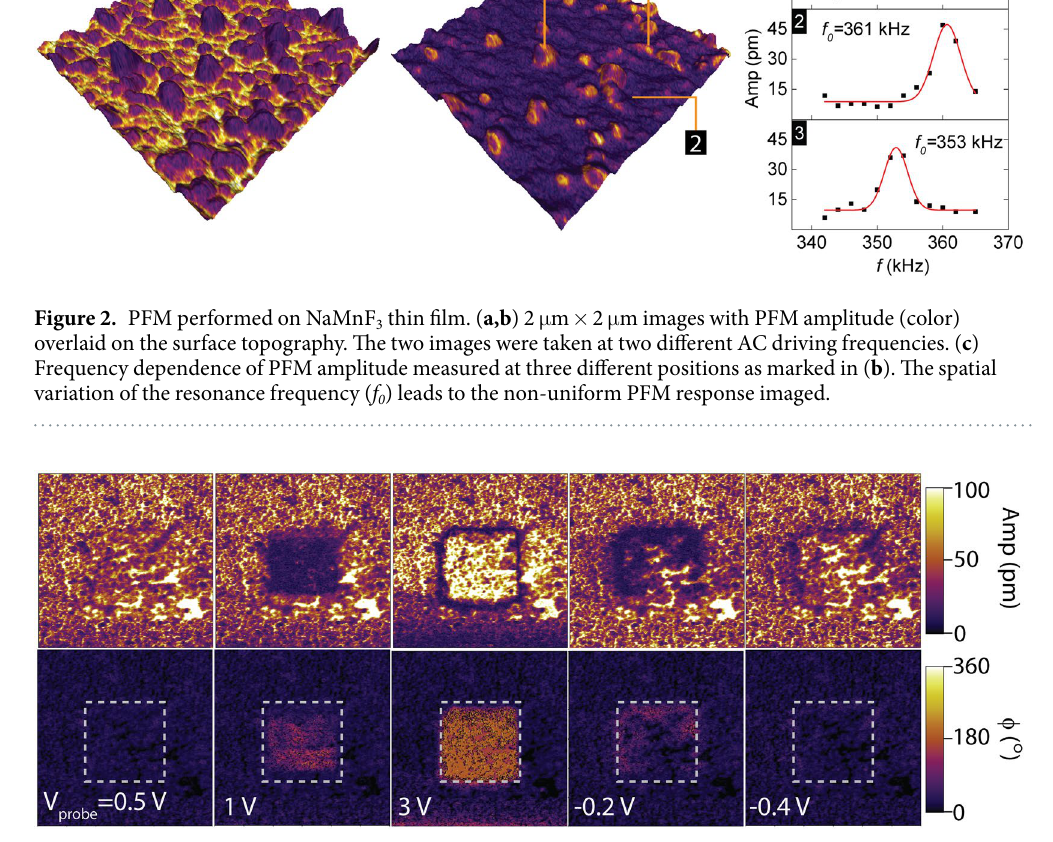
Figure 3. Ferroelectric switching by biased scanning probe. PFM amplitude (top) and phase (bottom) images of a 3 μ m × 3 μ m area consecutively taken after scanning over the center 1.5 μ m square (marked with the dashed line) with different probe